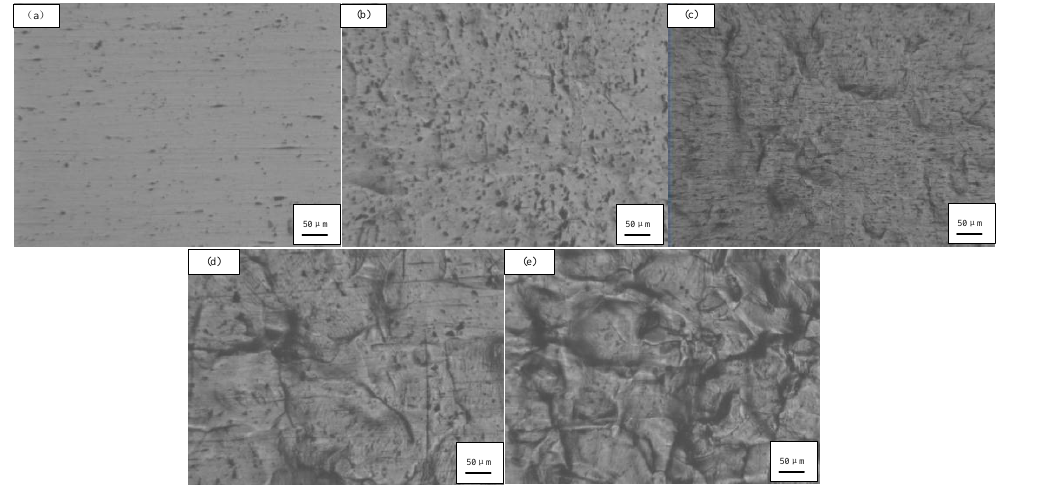
Figure 8. Surface morphology of stretched specimens with different strain variables: ( a ) 0%; ( b ) 3%; ( c ) 6%; ( d ) 9%; ( e ) 12%.